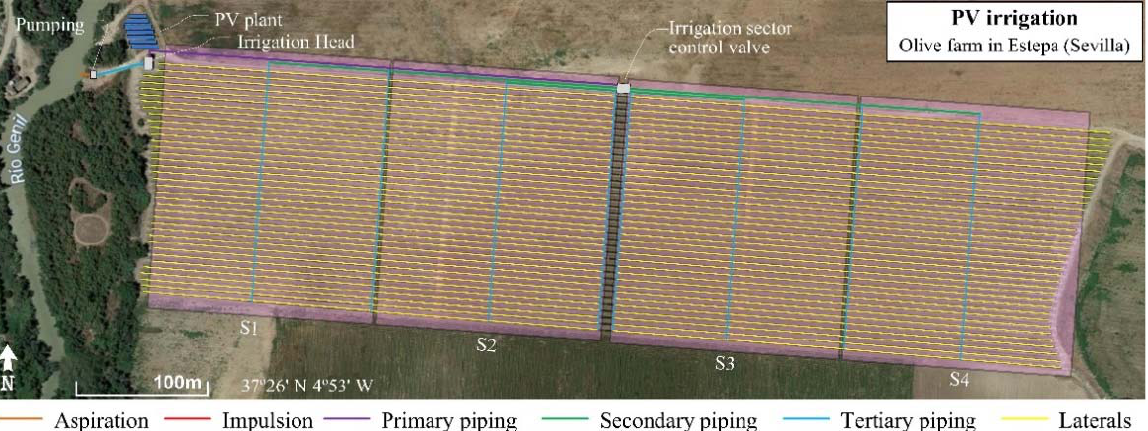
Figure 4. Olive grove farm and photovoltaic irrigation system. Table 5. Agronomic characteristics of the olive plantation. Variable.